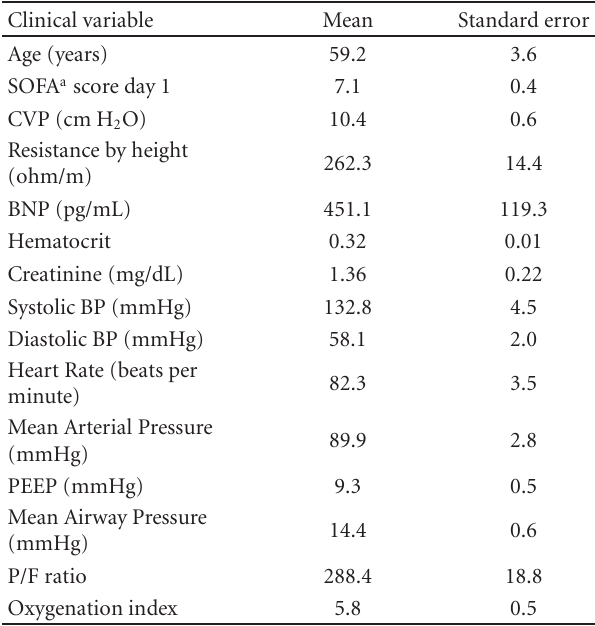
Table 1: Baseline characteristics ( N = 34).